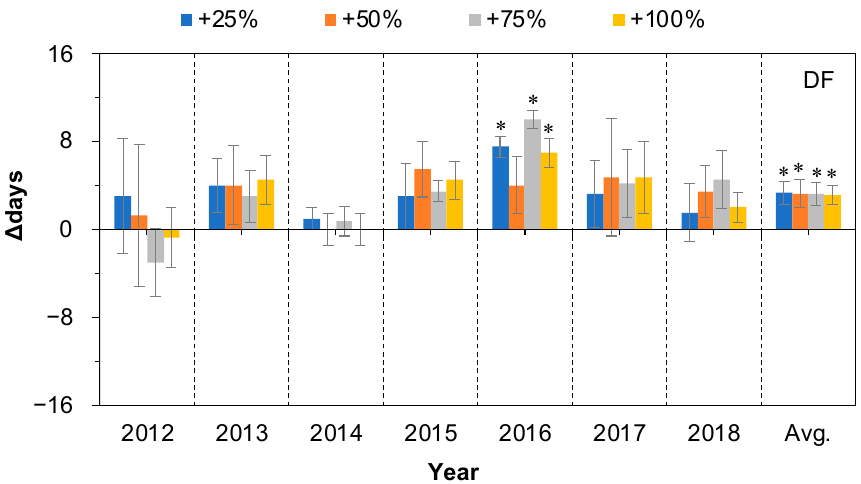
Figure 5. Relative changes ( △ days; mean ± SE) in the duration of fruiting period (DF) of Nitraria tangutorum after water addition treatments (+25%, +50%, +75%, +100%) compared with the control. Positive and negative values represent shortened and prolonged days, respectively. Avg. represents average values over the period from 2012 to 2018. * Significant differences from control.